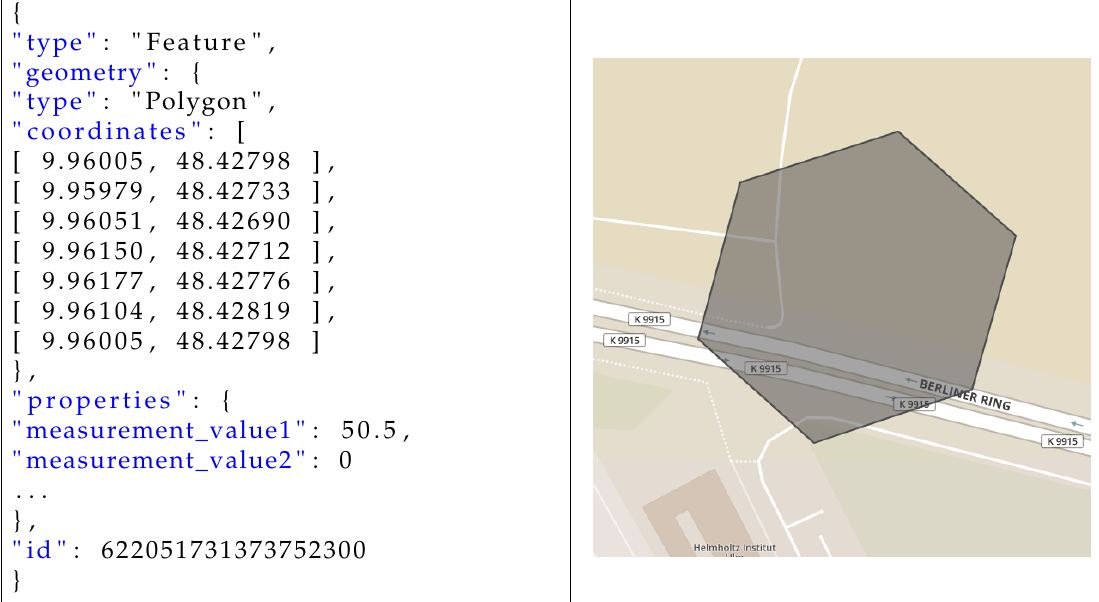
Figure 3. Example for GeoJSON feature object, including a polygon geometry and its visualization (Screenshot from